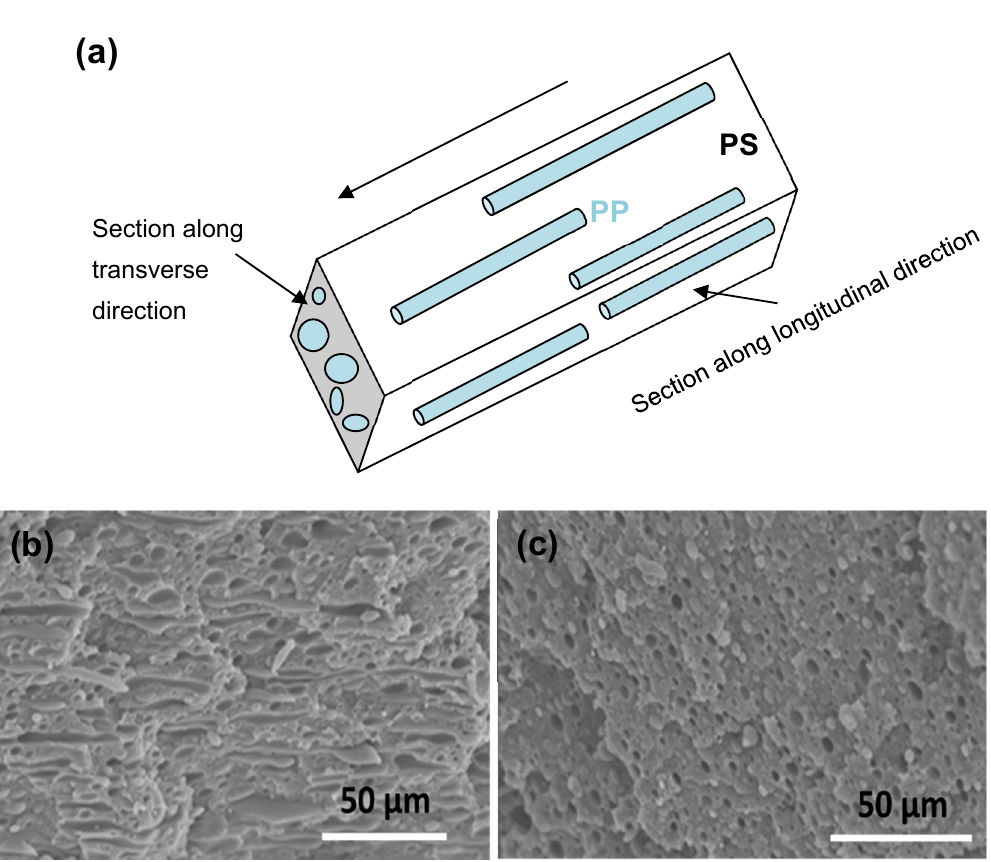
Figure 2. Detail of the microfibrillar morphology for dispersed PP in PS matrix developed by sample B0.9, in two directions relative to the flow direction in extrusion: ( a ) schematic of microfibrillar structure, ( b ) SEM image of section along longitudinal direction, and ( c ) SEM image of section along transverse direction.